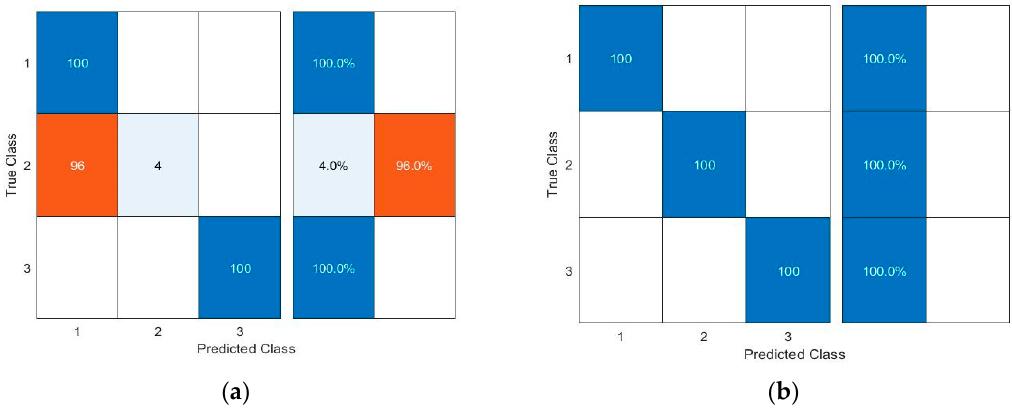
Figure 15. KNN confusion chart (trained at 1800 rpm, 3 Nm load; tested at 2400–3000 rpm, 0 Nm load): ( a ) all features; ( b ) robust features.